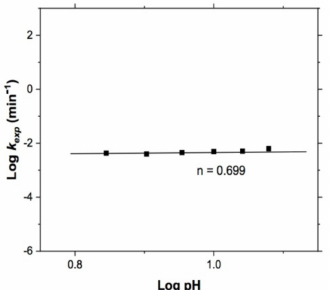
Figure 13. Flowsheet showing the process for the leaching of Cu contained in the WPCBs, using the thiosulfate–oxygen